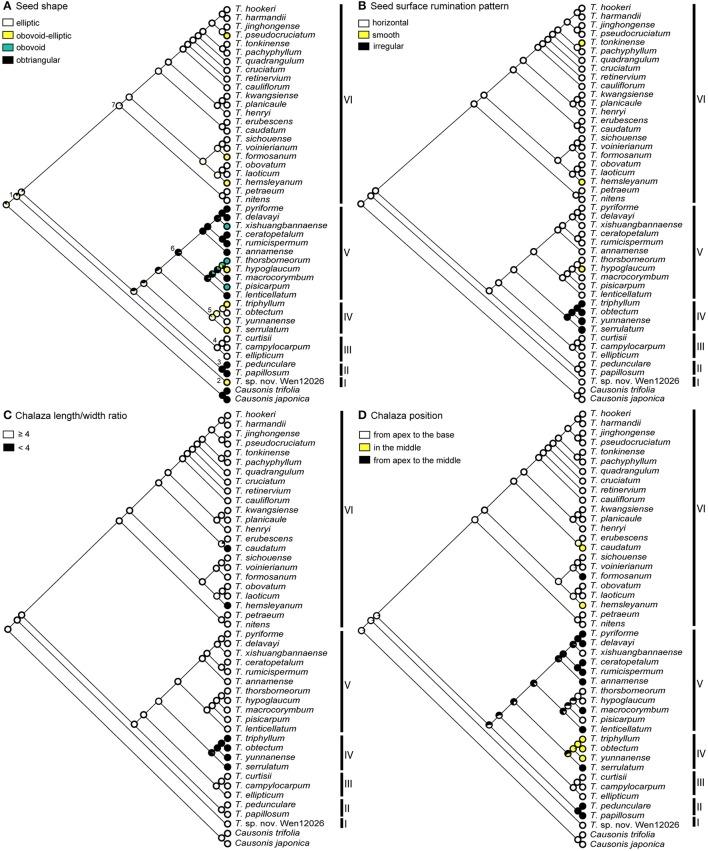
Optimization of key seed characters (1–4) based on Mk1 model implemented in Mesquite. (A) seed shape (character 1), (B) seed surface rumination pattern (character 2), (C) chalaza length/width ratio (character 3), and (D) chalaza position (character 4) inferred on a 46-terminal ML tree. Seven key nodes are marked in (A).